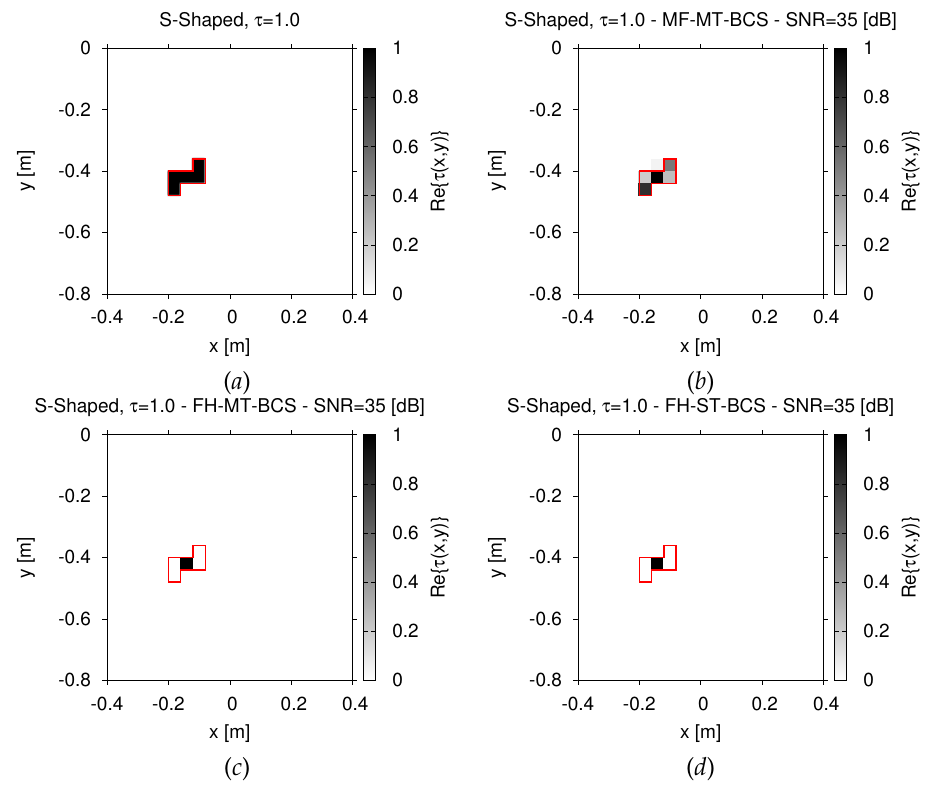
Figure 4. Numerical assessment (“ S-Shaped ” Scatterer , τ = 1.0, N = 400, SNR = 35 dB)—Actual ( a ) and retrieved ( b , d ) dielectric profile by ( b ) the MF-MT-BCS , ( c ) the FH-MT-BCS , and ( d ) the FH-ST-BCS